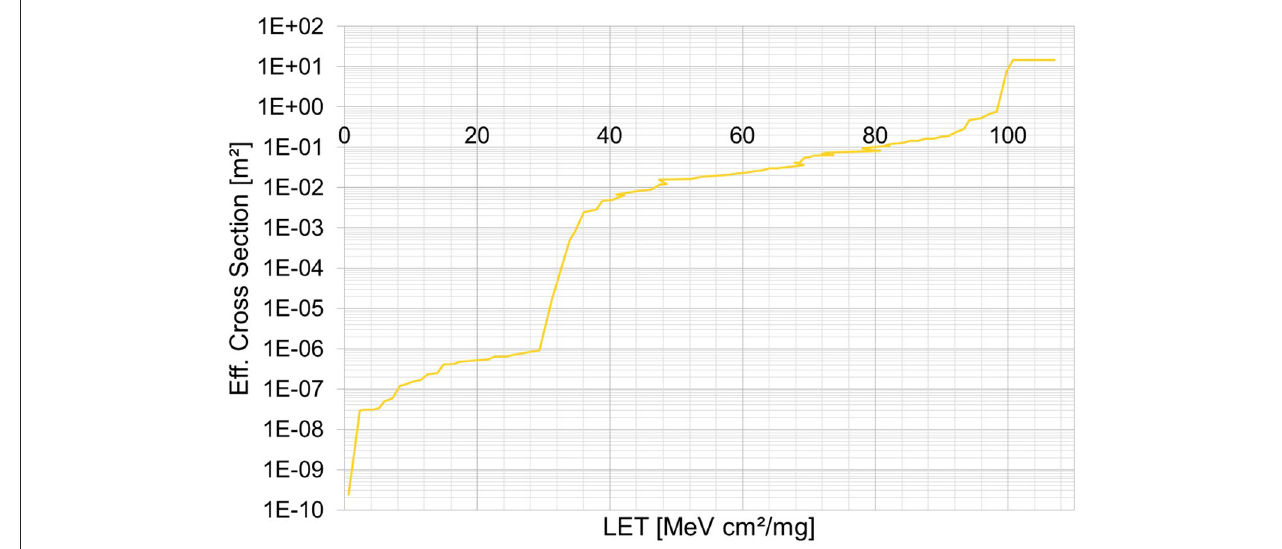
FIGURE 5 | Allowable system-level cross-section depending on particle LET at the GEO orbit.